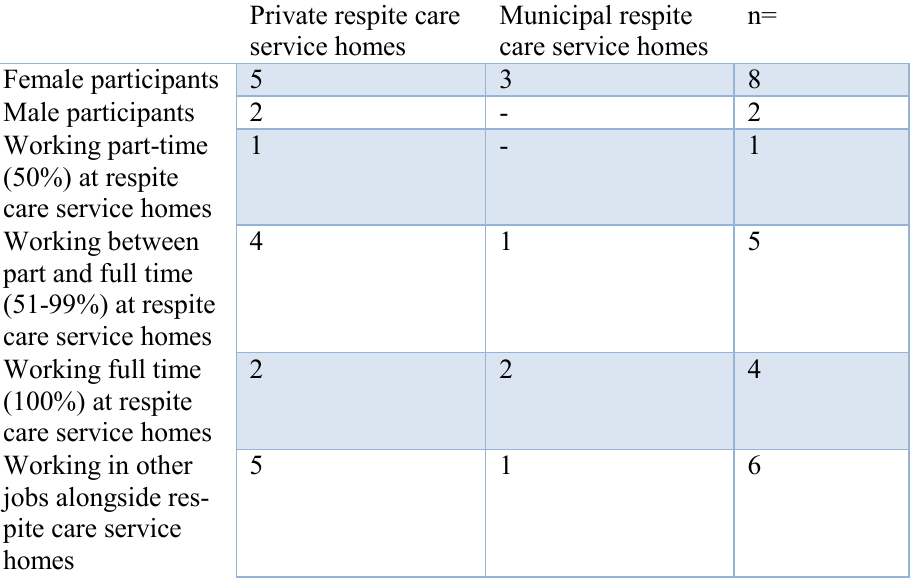
Private respite care service homes